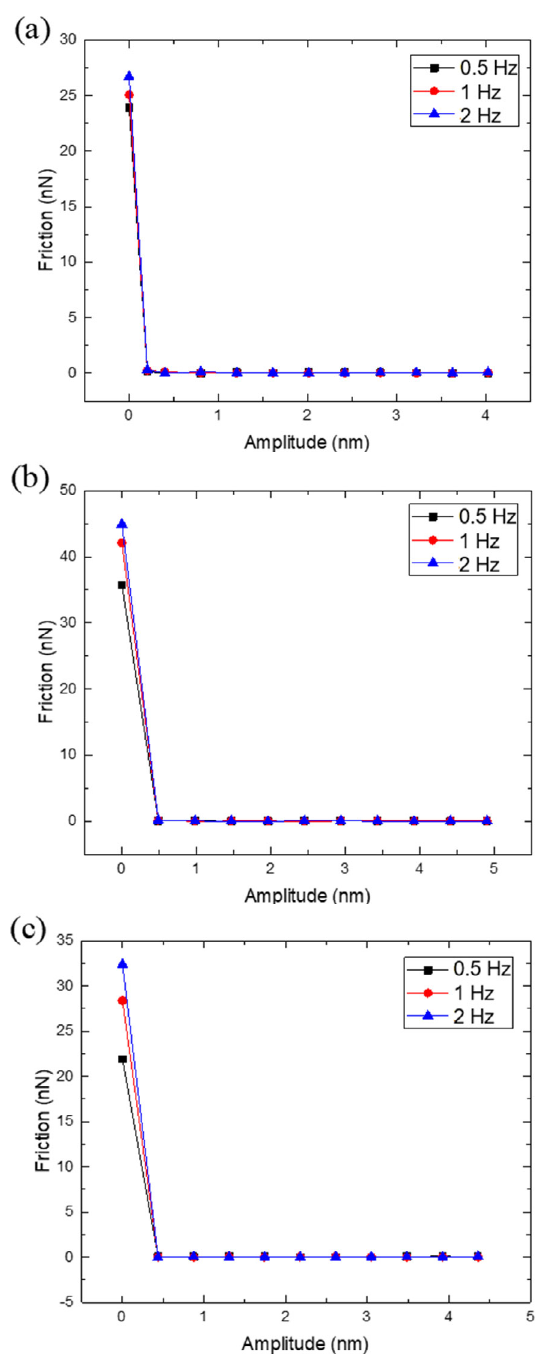
Fig. 9 Friction detected by scanning on the atomic-scale HOPG surface as a function of amplitude (0–5 nm) for the different directional vibrations: (a) z -directional, (b) x -directional, and (c) y -directional